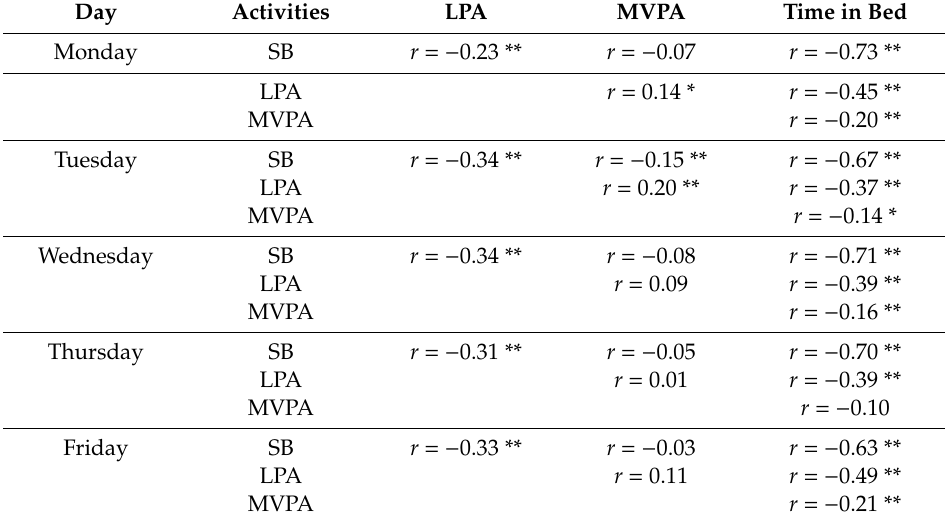
Table A1. Pearson correlation between SB, LPA, MVPA, and time in bed across each